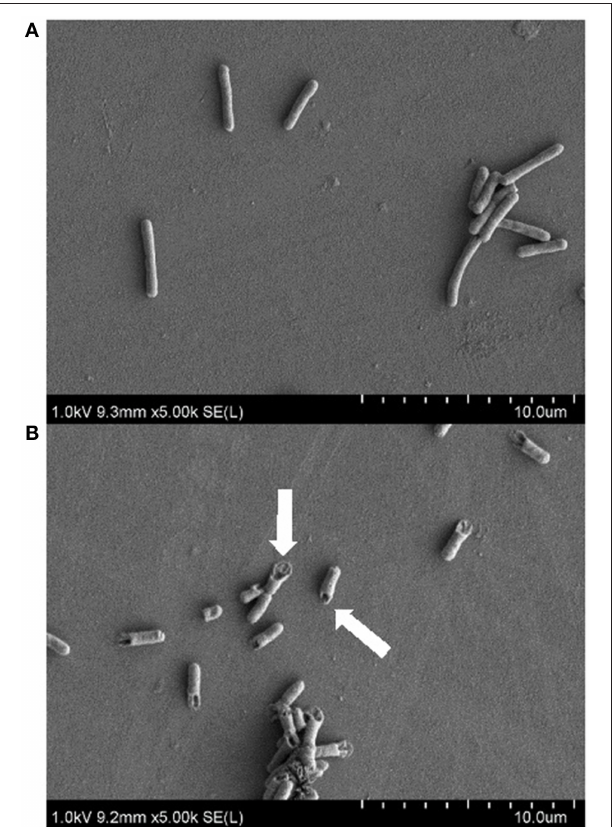
FIGURE 2 | Scanning electron microscopy images on the antimicrobial effect of active fraction produced by strain MSt1 T against E. coli ATCC 25922 at 5000x magnification. (A) Negative control (treatment with PBS); (B) Treatment with 0.1 mg/mL of active fraction produced by strain MSt1 T . Arrows points at the cell rupture of E. coli after treatment.